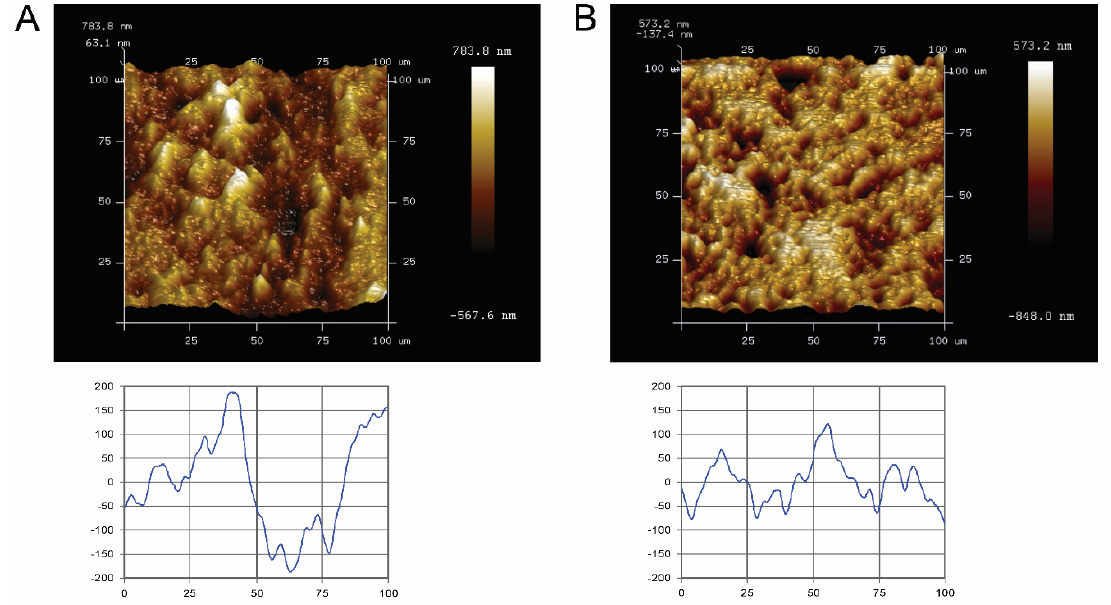
Figure 1. Atomic-force microscopy (AFM) images of representative specimen surfaces (100 × 100 µm 2 , upper panel), and corresponding scan profiles (lower panel) of the tested blocks. ( A ) titanium and ( B ) ceramic. Bright areas indicate high points, and dark areas indicate low points across the surface. (Lower graph: X- and Y-axes measured in micrometers).